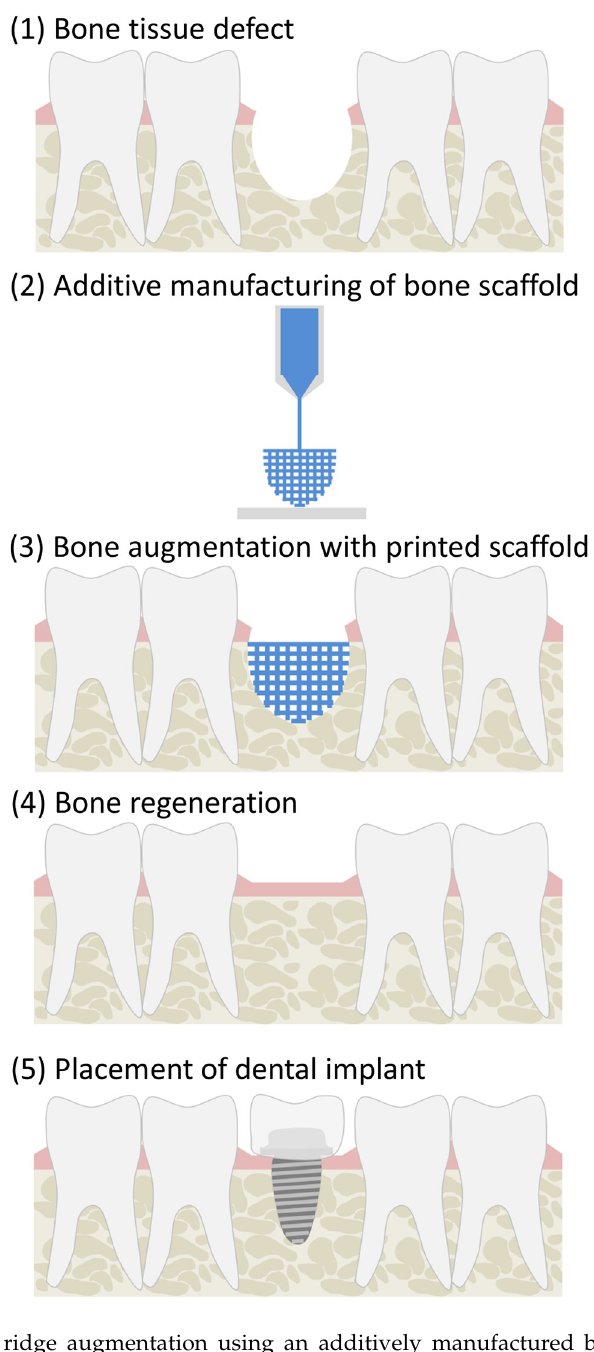
Figure 2. Alveolar ridge augmentation using an additively manufactured bone tissue scaffold. ( 1 ) a bone defect has formed in the alveolar ridge; ( 2 ) a bone scaffold is designed and then printed using additive manufacturing technology; ( 3 ) the printed bone scaffold is placed in the defect space to support bone regeneration; ( 4 ) new bone infiltrates the scaffold, eventually degrading or resorbing the structure; and, ( 5 ) a dental implant in positioned in the regenerated bone.